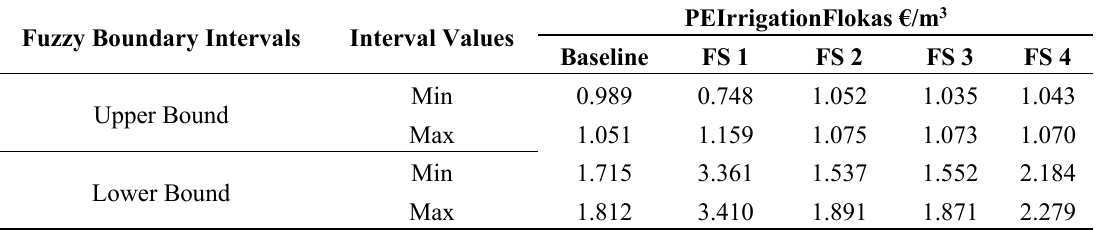
Table 9. Unit penalties for water allocated to irrigation, €/m 3 , for the baseline and the future scenarios.